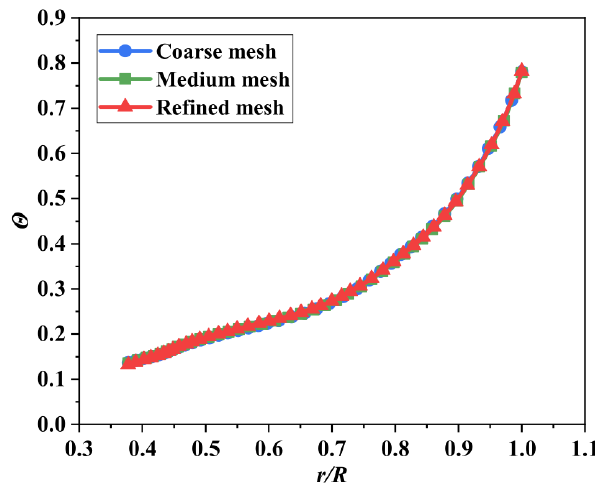
Figure 7. Validation of grid independence.